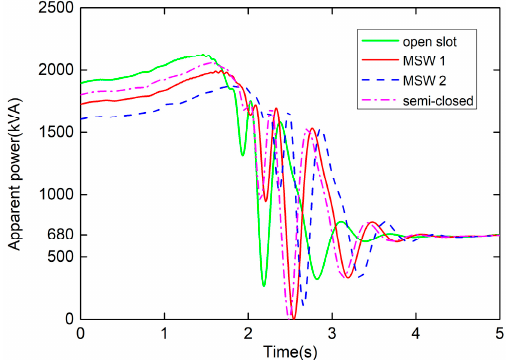
Figure 18. Apparent power vs. time.